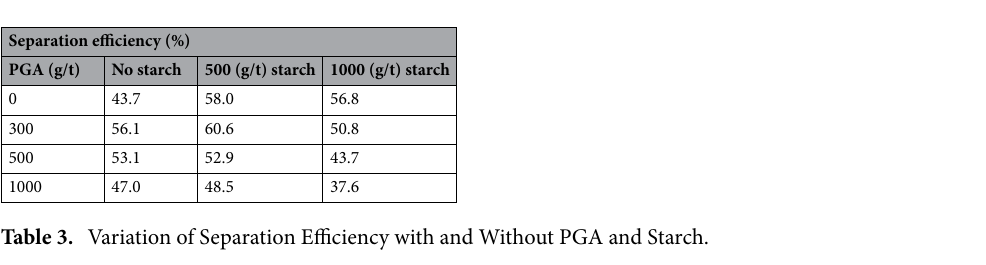
Figure 6. Effect of PGA and starch on magnetite flotation at a fixed amount of collector (300 g/t) at pH 10.